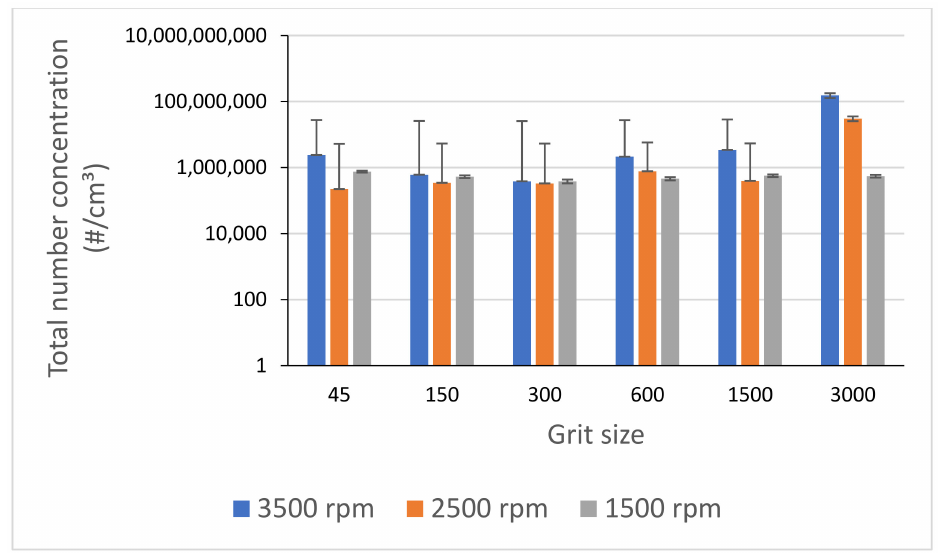
Figure 16. Total number concentration of UFP while grinding white granite for different spindle speeds (f = 1000 mm/min).